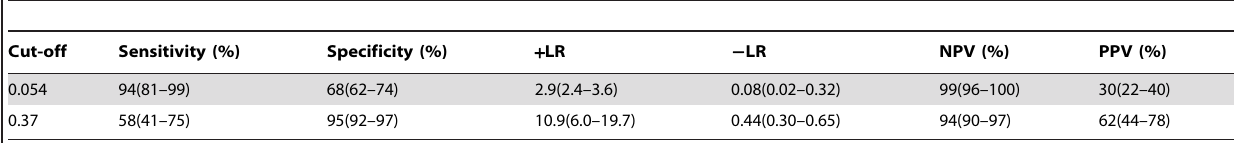
Table 2. Diagnostic accuracy for the proposed cut-off levels regarding the NoLI score for prediction of cirrhosis in 278 HCV- infected